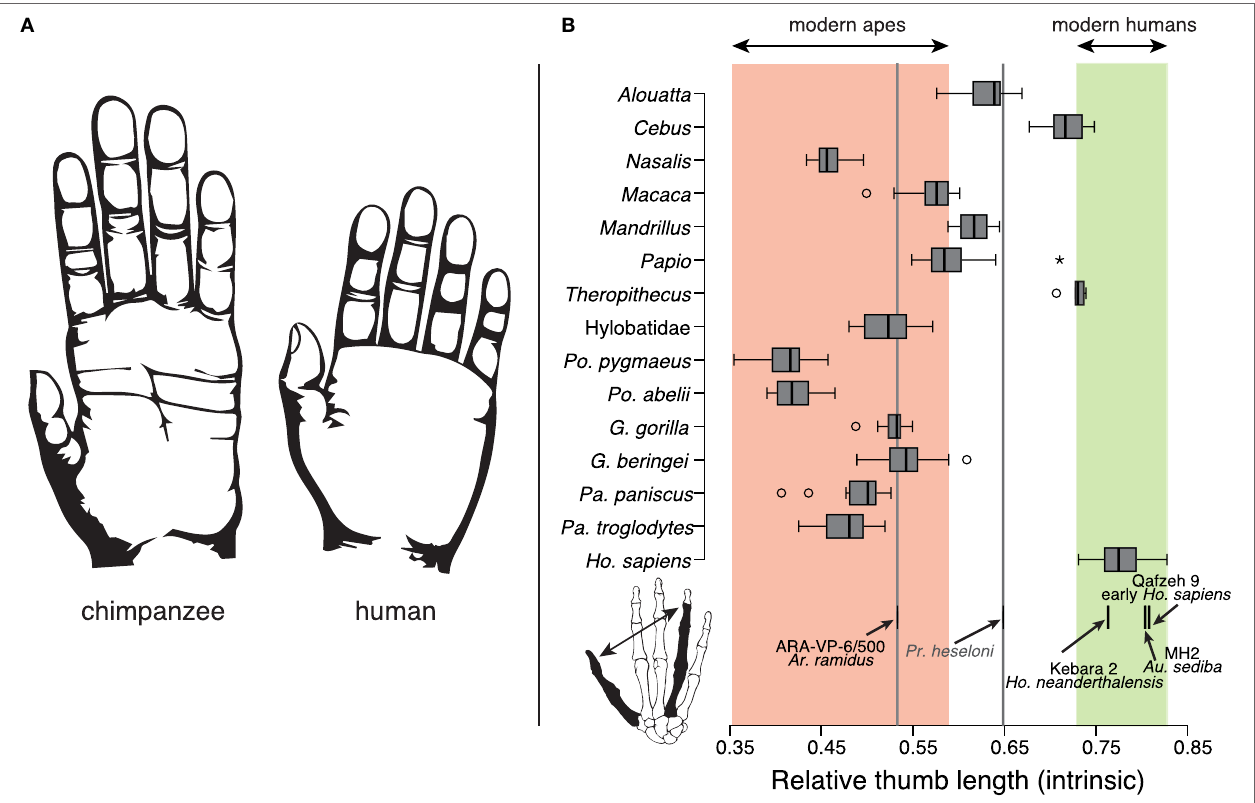
FiGURe 1 | (A) Chimpanzee and human hand comparison. (B) Thumb-to-fourth finger length ratios of modern apes and modern humans. Corresponding ranges are highlighted in red and green, respectively. The figure is reprinted with kind permission from Almécija et al.